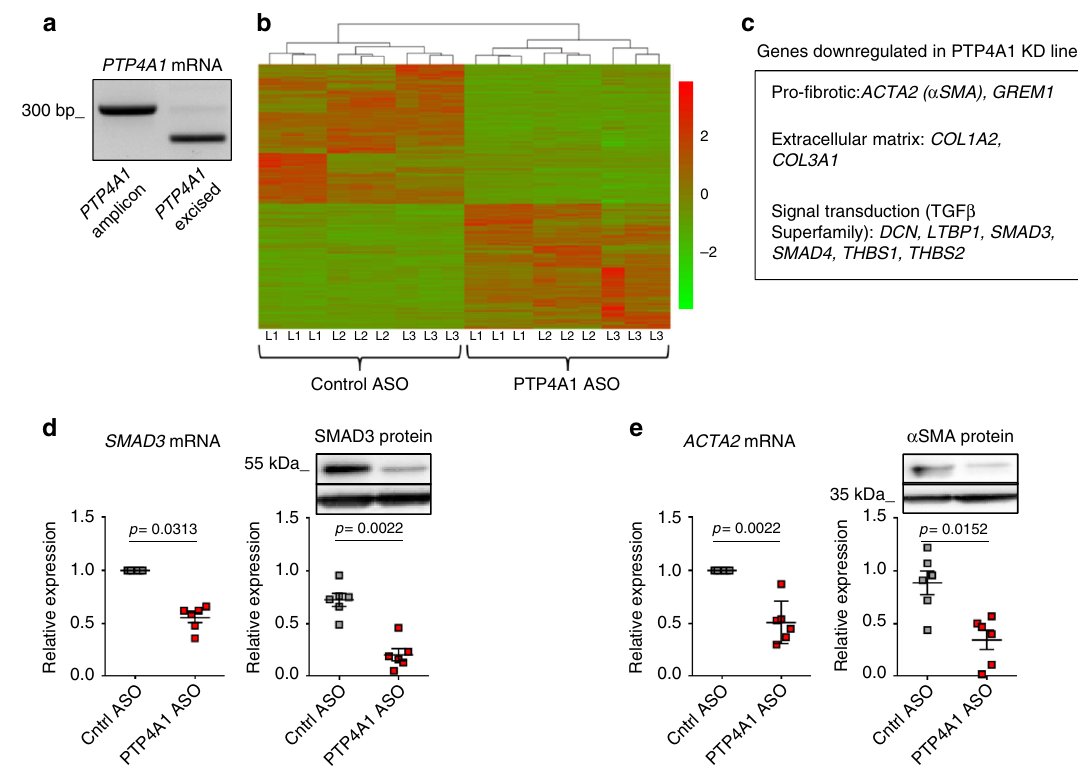
Fig. 2 Silencing of PTP4A1 downregulates pro- fi brotic genes in NHDF. a Agarose gel with RT-PCR of PTP4A1 mRNA from NHDF lines treated with control ASO (left lane) or with PTP4A1 ASO (right lane). b The heat map shows gene expression levels of three different NHDF lines (L1 – 3) treated with control ASO or PTP4A1 ASO. NGS was performed in triplicate for each NHDF line. c List of human pro- fi brotic genes downregulated in PTP4A1 KD NHDF lines, after DESeq analysis. d , e Left graphs show mean ± SEM of SMAD3 and ACTA2 mRNA expression measured in six different NHDF lines treated with PTP4A1 ASO and normalized to same lines treated with control ASO. Right graphs show mean ± SEM of densitometric scan expression plus representative immunoblotting for SMAD3 and α SMA (upper bands) normalized to GAPDH (lower bands) in six different NHDF lines treated with control ASO or PTP4A1 ASO. Wilcoxon test ( d , e left) or Mann – Whitney test ( d , e